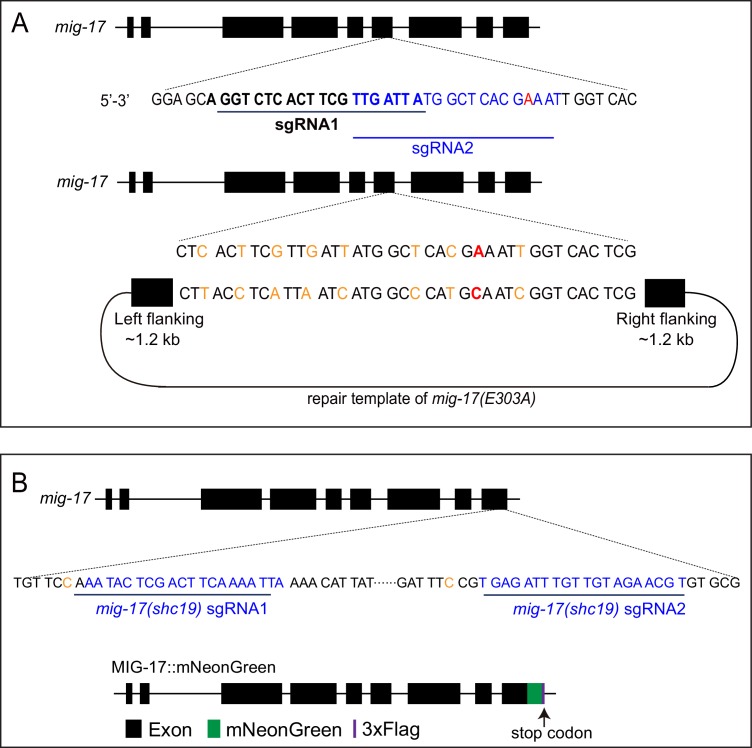
CRISPR strategies to generate the mig-17(shc8) allele and the endogenous MIG-17::mNeonGreen.(A) Schematic of the strategy used to change E303 at MIG-17 and generate the mig-17(shc8) allele. The location for the two sgRNAs used (black bolded and blue) and the shc8 (E303A) repair template are indicated. The repair template comprised of 1.2 kb upstream and 1.2 kb downstream genomic sequence flanking the enzymatic active site E303. The Glutamic acid (GAA) at the 303 was changed into Alanine (GCA) (red). Eight synonymous mutations were made to prevent Cas9 from cutting the repair template (orange). sgRNA design is based on sgRNA design tool (http://crispr.mit.edu). (B) Schematic of the strategy used to fuse to the C-terminus of the endogenous genomic mig-17 locus with mNeonGreen (Dickinson et al., 2013). Briefly and as indicated, two sgRNAs (blue) were used to insert mNeonGreen::3 × Flag into the MIG-17 C-terminus via CRISPR. The mig-17 exons are indicated in the schematic by black boxes; the green and purple boxes represent mNeonGreen and 3xflag tags. Two synonymous mutations at the PAM sites were made on the repair templates (orange) to avoid cutting by Cas9. We examined the glia morphology and gonad defect in mig-17::mNeonGreen knock-in animals, and observed that they behave as wild type, suggesting that MIG-17::neonGreen does not compromise MIG-17 function (data not shown).